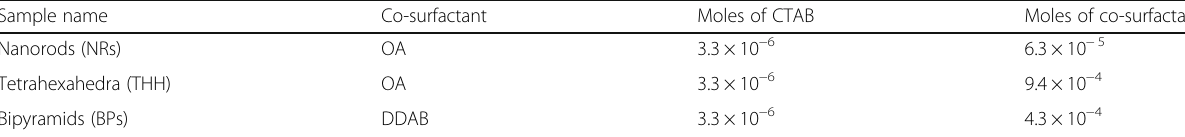
Table 1 Moles of CTAB and co-surfactant used for the synthesis of various shapes of Au NS